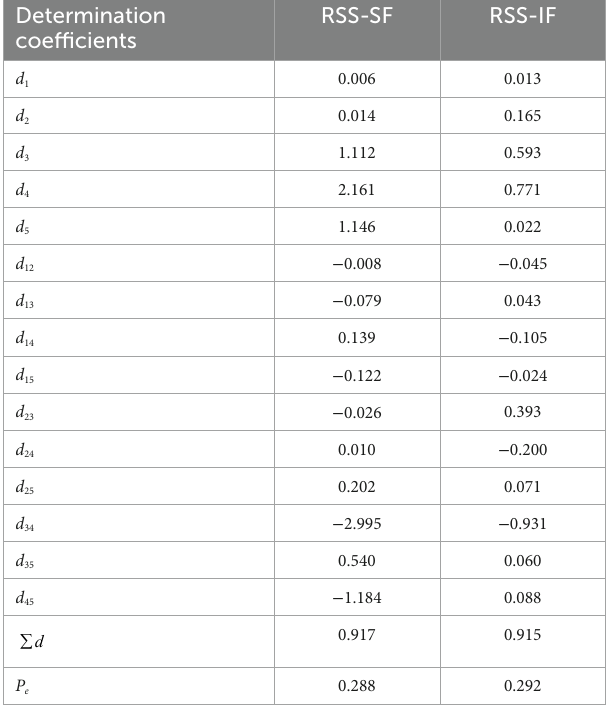
TABLE 3 Determination coefficients in group RSS-SF and RSS-IF.